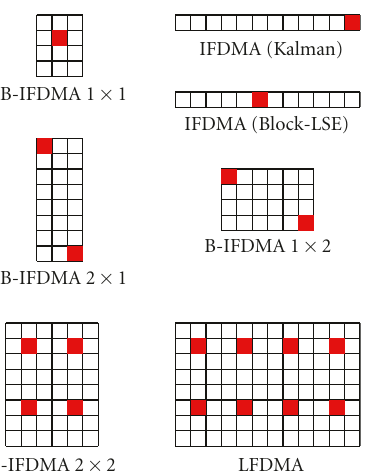
Figure 7: The pilot patterns used for the investigated block allocations that use combinations of a basic block of 4 subcarriers by-3-OFDM-symbols, with one pilot and 11 payload symbols (i.e., pilot overhead 1 / 12): B-IFDMA 1 × 1 ( M = 4, N t = 3), 1 × 2 ( M = 4, N t = 6), 2 × 1 ( M = 8, N t = 3), 2 × 2 ( M = 8, N t = 6), IFDMA ( M = 1, N t = 12), and LFDMA ( M = 8, N t = 12). Time axis is horizontal and frequency axis is vertical in this figure. The pilot positions within blocks have been determined by global optimization of the channel estimation performance of the Block- LSE (Wiener) method, and they di ff er from those specified for uplinks in [4, 5].